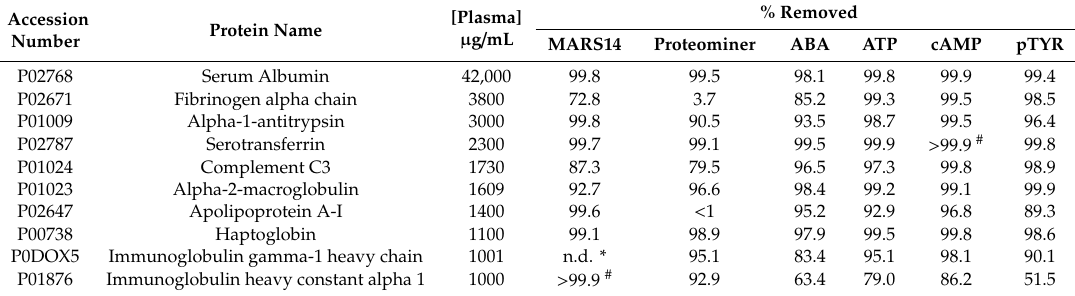
Table 1. The efficiency of the removal of the most abundant 14 plasma proteins by the MARS 14 immunodepletion and ProteoMiner and the four affinity-based approached from human plasma as determined by label free quantification as described in the methods section. Figures shown represent a decrease in signal for the specific protein (in %) after enrichment/depletion, relative to signals obtained from the analysis of un-depleted plasma. Calculation of “% Removed” is based on the mean the signal of six replicate experiments as percentages of the mean of the signal obtained from the analysis of six replicate analysis of un-depleted plasma (see supplementary Table S1). The concentrations of the measured proteins in plasma is based on values extracted from the plasma proteome database (http://www.plasmaproteomedatabase.org). Abbreviations: agarose-immobilized benzamidine (ABA); O-Phospho-L-Tyrosine (pTYR); 8-Amino-hexyl-cAMP (cAMP) and 8-Amino- hexyl-ATP (ATP); Multi Affinity Removal System (MARS) 14.